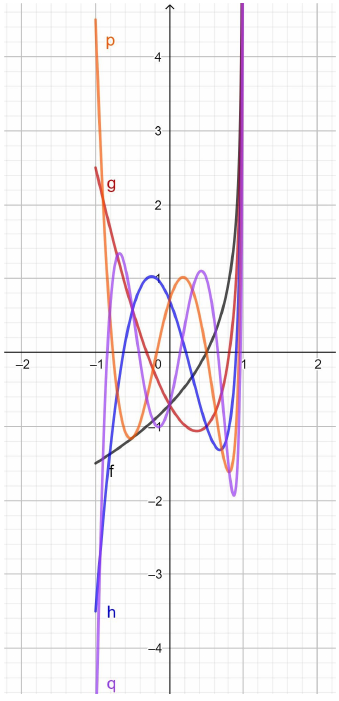
Figure 5. V k + 1/2 , k = 1,2,3,4,5. 1, grey; 2, red; 3, blue; 4, orange; 5, violet.